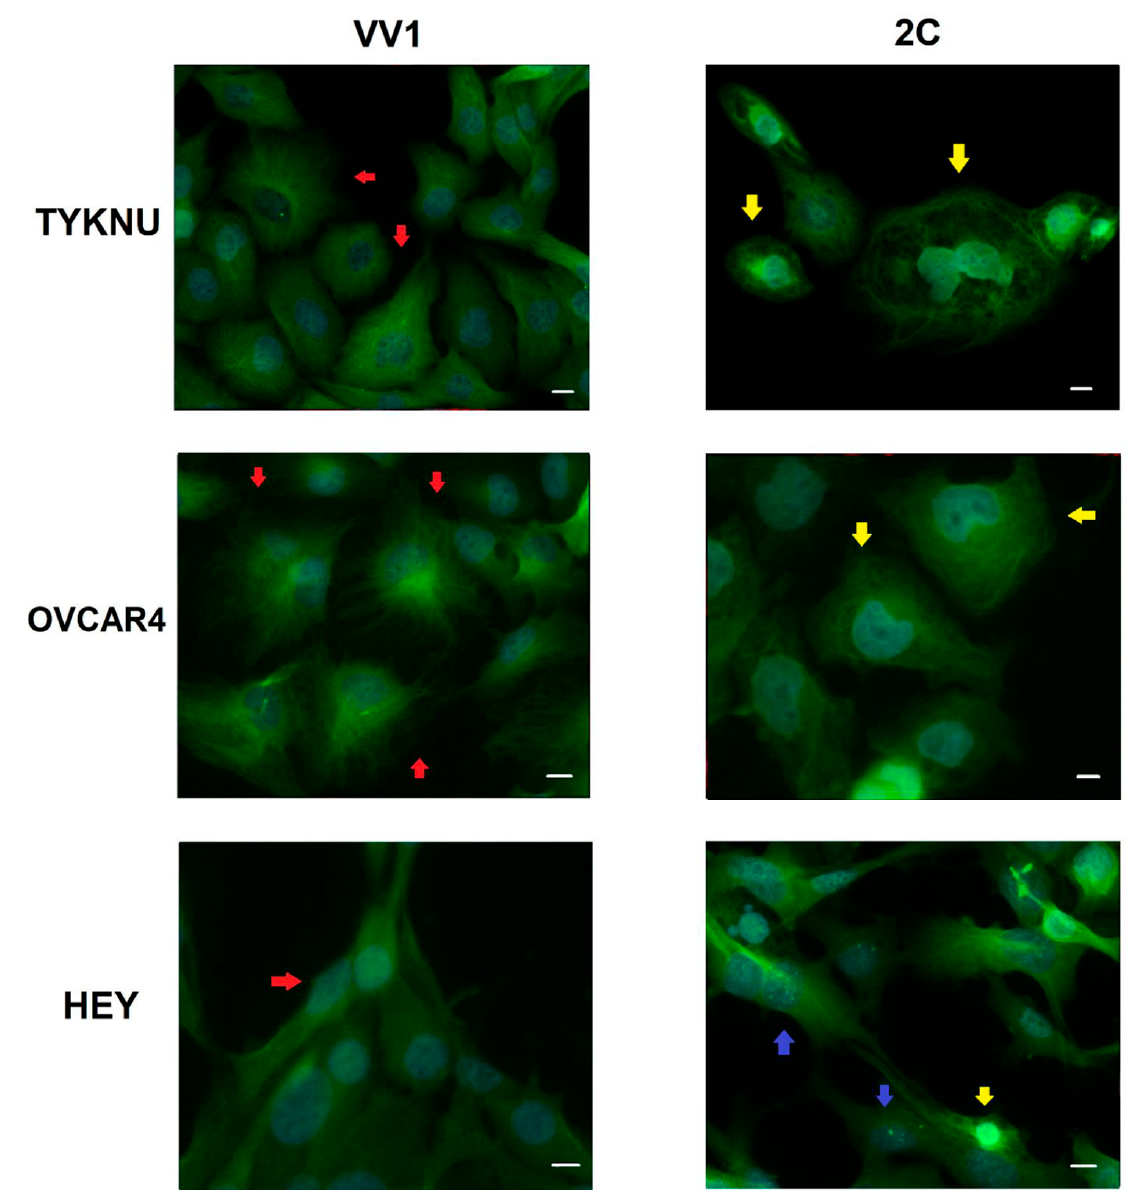
Figure A2. Images of β -tubulin immunofluorescence staining for TYKNU, OVCAR4 and HEY cell lines treated with VV1 (negative control) and 2c. In blue, the DAPI-marked nuclei. Red arrow: ”bush” microtubules network; Yellow arrow: disrupted microtubules; Blue arrow: Nuclear high-intensity point. Scale bar = 10 μ m.